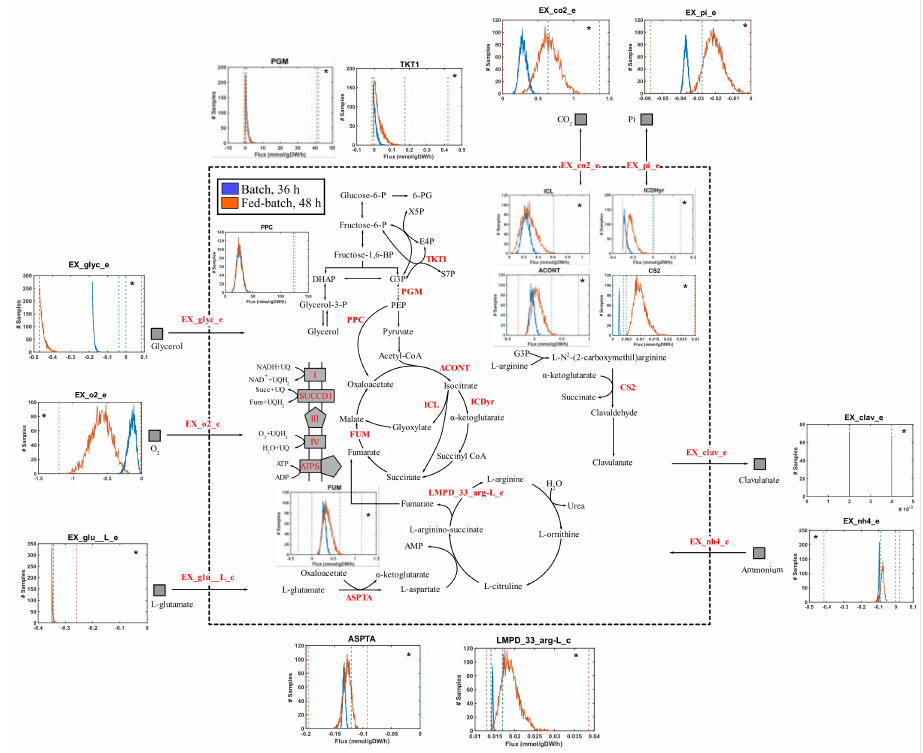
Figure 3. Summary of intracellular and exchange flux distributions in the S. clavuligerus reduced metabolic network for Table 2. Distributions indicated with blue, and orange represent the metabolic scenarios in batch (36 h) and fed-batch mode (48 h), respectively. Dotted lines represent flux ranges of FVA. The significantly different distributions ( p < 0.001, Kruskal—Wallis test) have been marked with an asterisk (*). The reaction names with the prefix EX_ corresponds to the exchange reactions of consumed or produced metabolites by S. clavuligerus . glu__L: L-glutamate, o2: Oxygen, glyc: glycerol, co2: CO 2 , pi: phosphate, clav: clavulanic acid, nh4: NH 4+ . For a better discrimination of flux sampling distributions, please refer to Figure